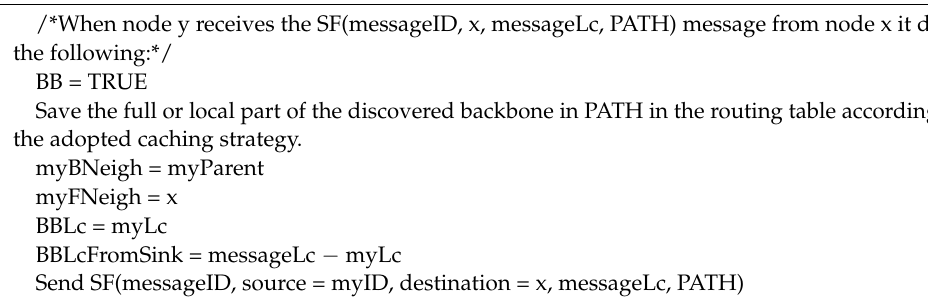
Algorithm 4: BD at an intermediate node. Reception of an SF message from the